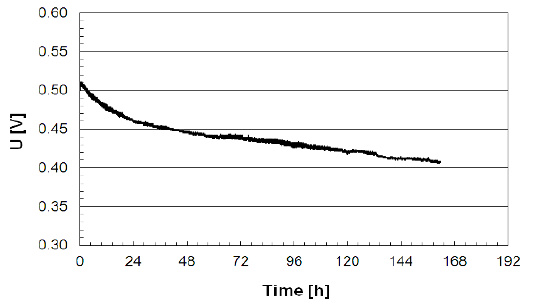
Figure 5. The effect of 1.5 ppm H S on the SOFC cell performance at 200 mA cm -2 current density at 750°C for the fuel (50%H 2 with 3% H O (left) and fit to logarithmic performance decline model 2